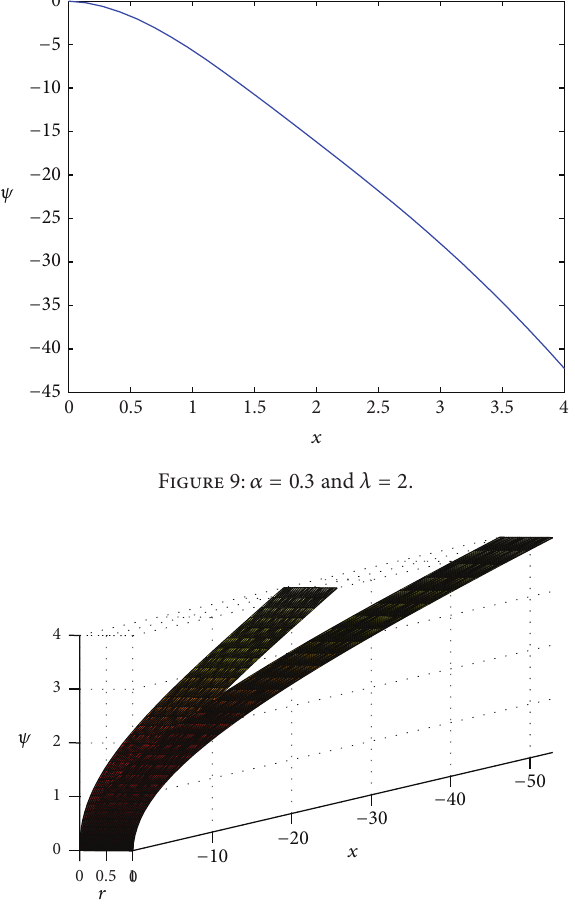
Figure 10: 𝛼 = 0.8 and 𝜆 = 2